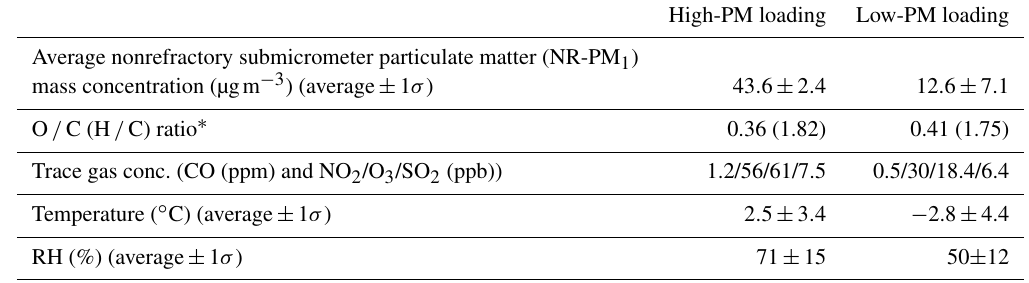
Table 3. Comparison of aerosol properties and meteorological parameters between the high-loading and low-loading periods.